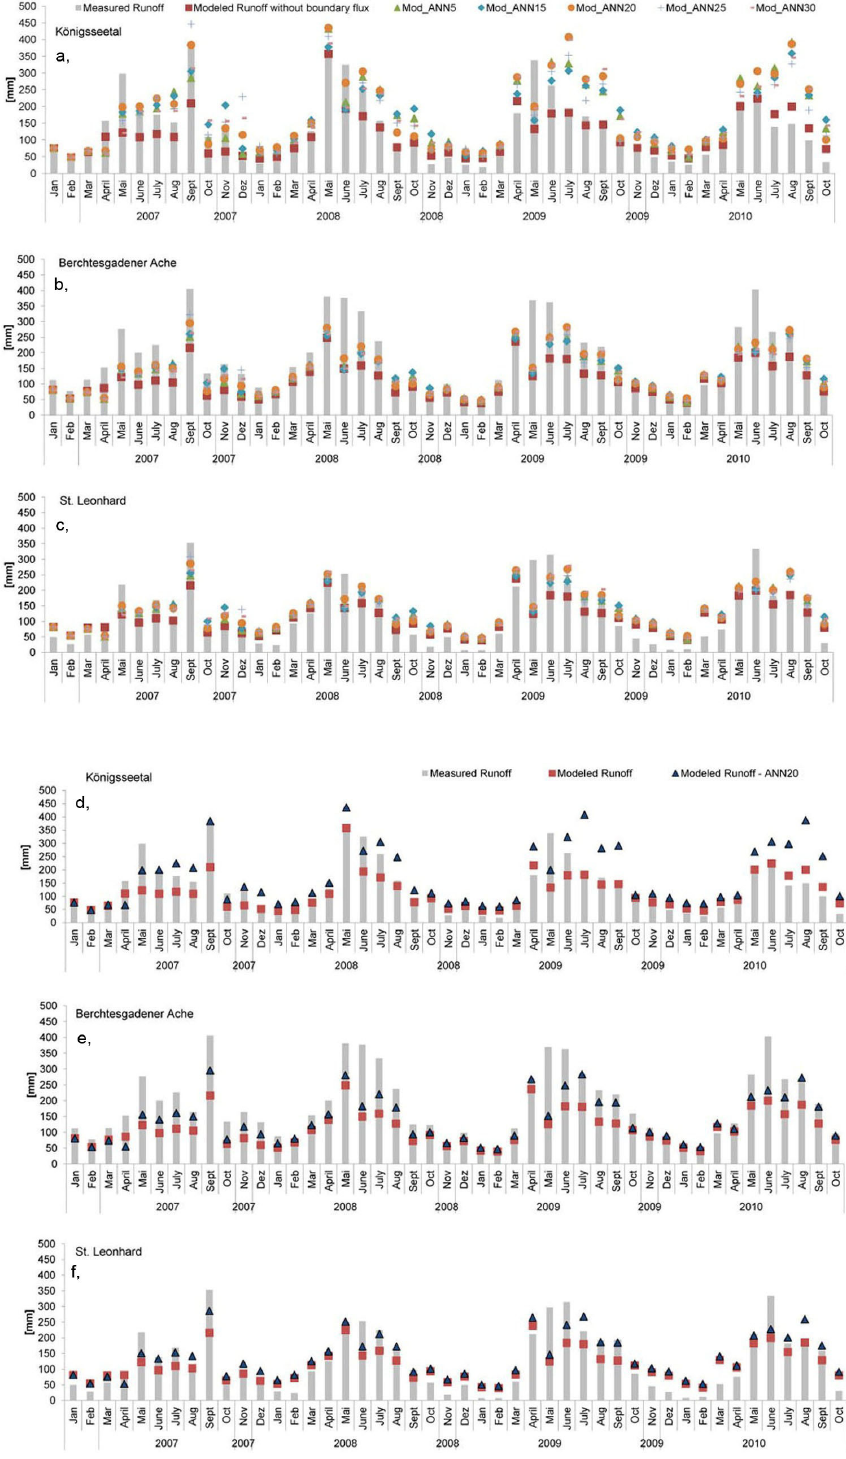
Fig. 15. Monthly sums of measured runoff and hydrological model runoff with and without implemented boundary flux from June to October for years 2007–2010 for subbasin K¨onigsseetal, Berchtesgadener Ache and St. Leonhard. (a) , (b) , (c) : Results of influxes of all time increments in subbasin K¨onigsseetal, Berchtesgadener Ache and St. Leonhard. Mod-ANN5=5 days, Mod-ANN15=15 days, Mod- ANN20=20 days, Mod-ANN25=25 days, Mod-ANN30=30 days. (d) , (e) , (f) : Results for the ANN with 20-day time increment, which showed best performance in the hydrological model